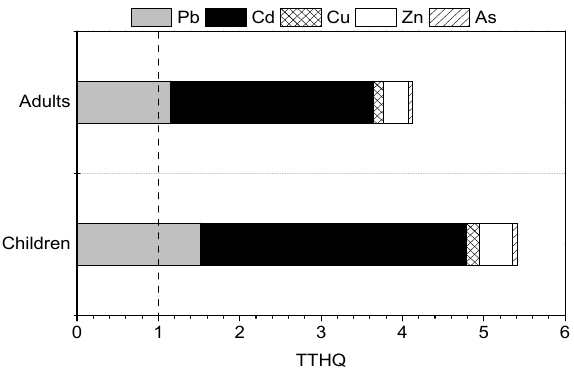
Figure 3. TTHQ values due to consumption of vegetables.